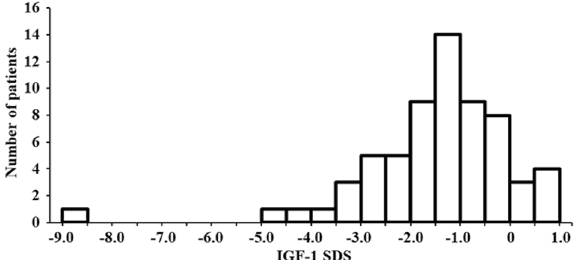
Figure 1. Histogram showing the number of the patients per IGF-1 SDS category. IGF-1 insulin like growth factor-1, SDS standard deviation